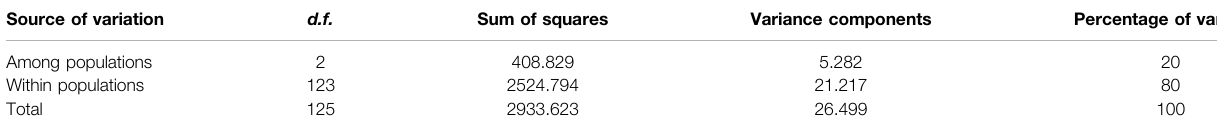
TABLE 7 | Analysis of molecular variance (AMOVA) in three populations of Schizothorax biddulphi . Source of variation